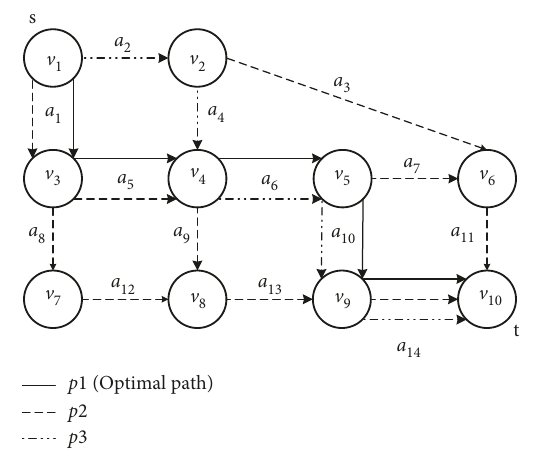
Figure 3: Path selection